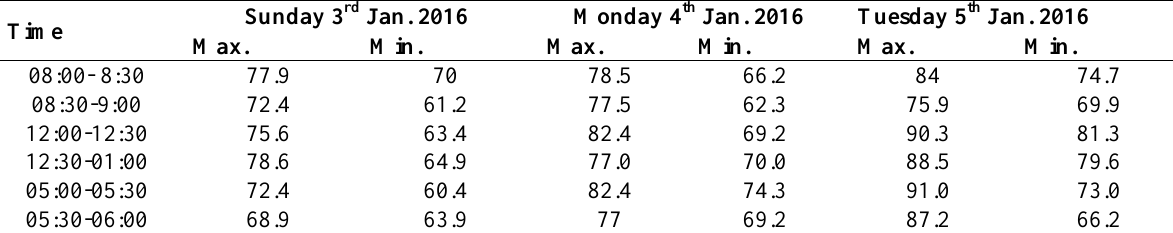
Table 5, Noise measurements pollutions levels in dB(A) at Baghdad street.